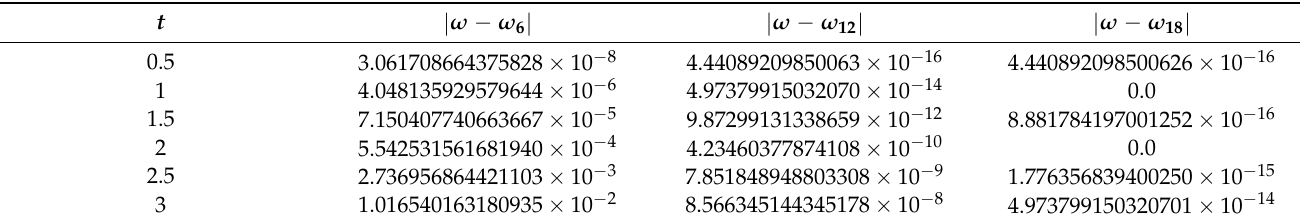
Table 1. Comparison of absolute errors of the nonlinear time-FBPM